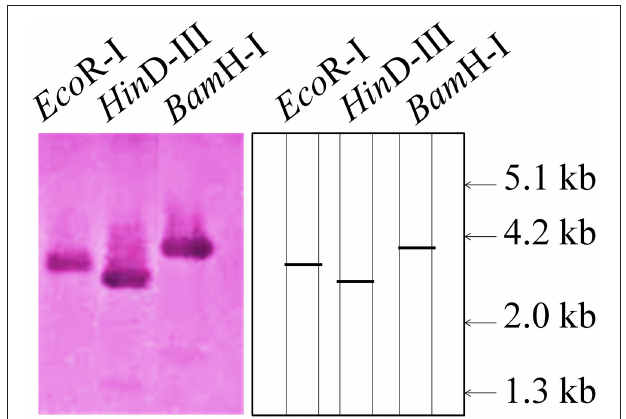
FIGURE 2 | Southern blot analysis to identify the copy number of cloned RuBisCo activase ( TaRca1 ) gene from wheat cv . HD2985; Eco RI, Hin DIII, and Bam HI enzymes were used for the restriction; 12 µ g genomic DNA was used per sample; 0.8% agarose gel was used for the electrophoretic separation of restricted product; Biotin-labeled probe was used for the hybridization.